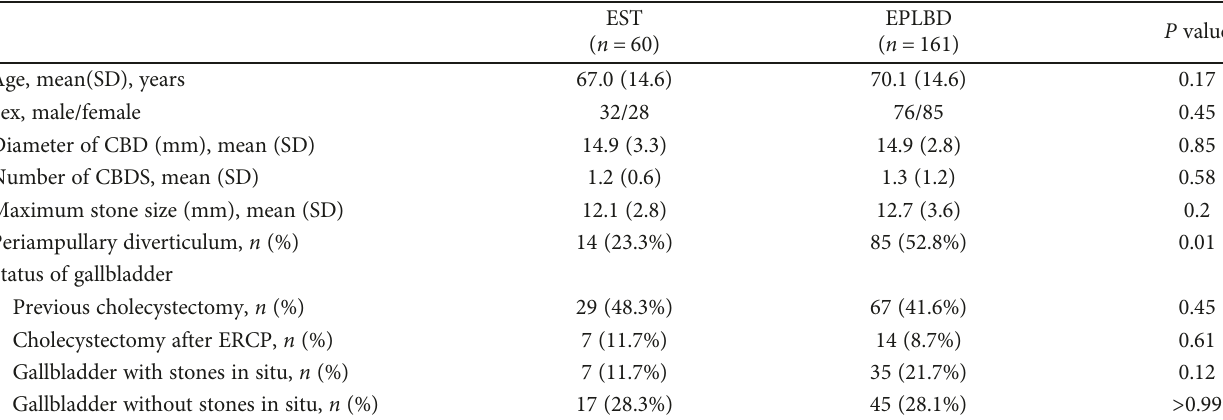
Figure 2: Endoscopic papillary large balloon dilation alone was performed. Table 1: Baseline characteristics of the study patients who underwent EPLBD and